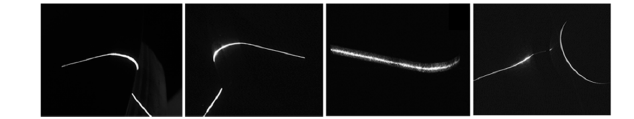
Figure 21. Wheelset dynamic measurement system installed on the railway bed.